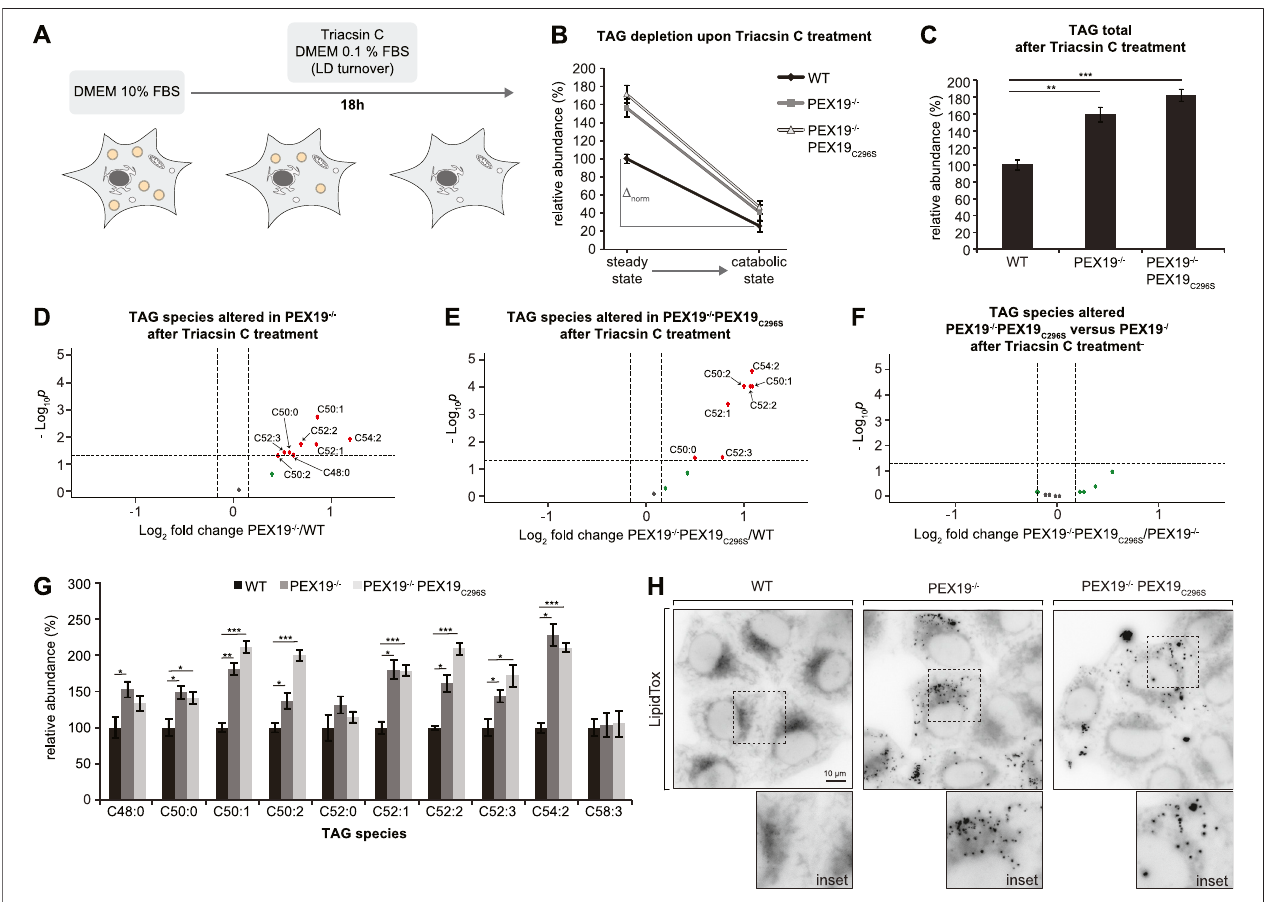
FIGURE5| TAGsand LDs cannotbe fullydepleted inPEX19-compromised cells. (A) Schematic outlinedepictingthatcells wereshiftedtocatabolicconditions by incubationinDMEMmediumwith0.1%FBSandinpresenceofTriacsinCfor18 h. (B – G) Shotgun-lipidomicsresultsforTAGspeciesuponTriacsinCtreatment. (B) Plot indicating TAG depletion upon Triacsin C treatment for WT, PEX19 − / − and PEX19 − / − PEX19 C296S cells (Starting points = steady state; endpoints = catabolic state). TAG valueswerenormalized to100%inWTcellsundersteadystateconditionsbeforeTriacsinCtreatment.RelativeTAGdepletionuponTriacsinCtreatment overnight is74.4%inWT,73.9%inPEX19 − / − and72.9%inPEX19 − / − PEX19 C296S cells. Δ norm indicatestheabsoluteTAGdepletionasde fi nedbythedifferenceofTAGlevelsunder steady state conditions before Triacsin C treatment and TAG levels at catabolic state for each cell line and is 74 for WT, 116 for PEX19 − / − and 125 for PEX19 − / − PEX19 C296S cells. (C) Bar diagram showing the relative abundance of total TAG species remaining after Triacsin C treatment in WT, PEX19 − / − and PEX19 − / − PEX19 C296S cells. Values were normalized to 100% in WT cells. (D – F) Volcano plots of TAG subspecies analyses. 10 TAG species were analyzed and logarithmically plotted against the p -value (derived from unpaired, two-sided Student ’ s t-test) after FDR-correction, illustrating changes in PEX19 − / − cells (D) and PEX19 − / − PEX19 C296S cells (E) compared to WT cells, respectively, as well as changes between PEX19 − / − and PEX19 − / − PEX19 C296S cells (F) . Grey dots: lipid species without signi fi cant changes. Green dots: lipid species with a fold change greater than the average SEM but with a p -value > 0.05. Red dots: signi fi cantly altered ( p -value < 0.05) lipid species with a greater fold change than the average SEM. (G) Bar diagram showing the relative abundance of TAG species in WT, PEX19 − / − and PEX19 − / − PEX19 C296S cells.ErrorbarsindicateSEMandstatisticalsigni fi cancebetweenthegroupswasdeterminedbyanANOVAfollowedbyTukeypost-hoctest.*,**, *** indicate p -values < 0.05, < 0.01, and < 0.001, respectively. Non-signi fi cant changes are not indicated. For each cell line 8 individual samples were analyzed with three technical replicates each. (H) Micrographs showing LipidTox-staining of living WT, PEX19 − / − and PEX19 − / − PEX19 C296S cells as indicated. Inverted, maximum intensity projections of z-stacks are shown. Scale bar: 10